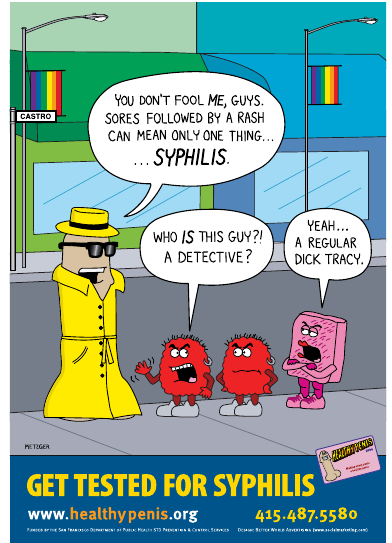
Figure 2. Example of Healthy Penis Campaign